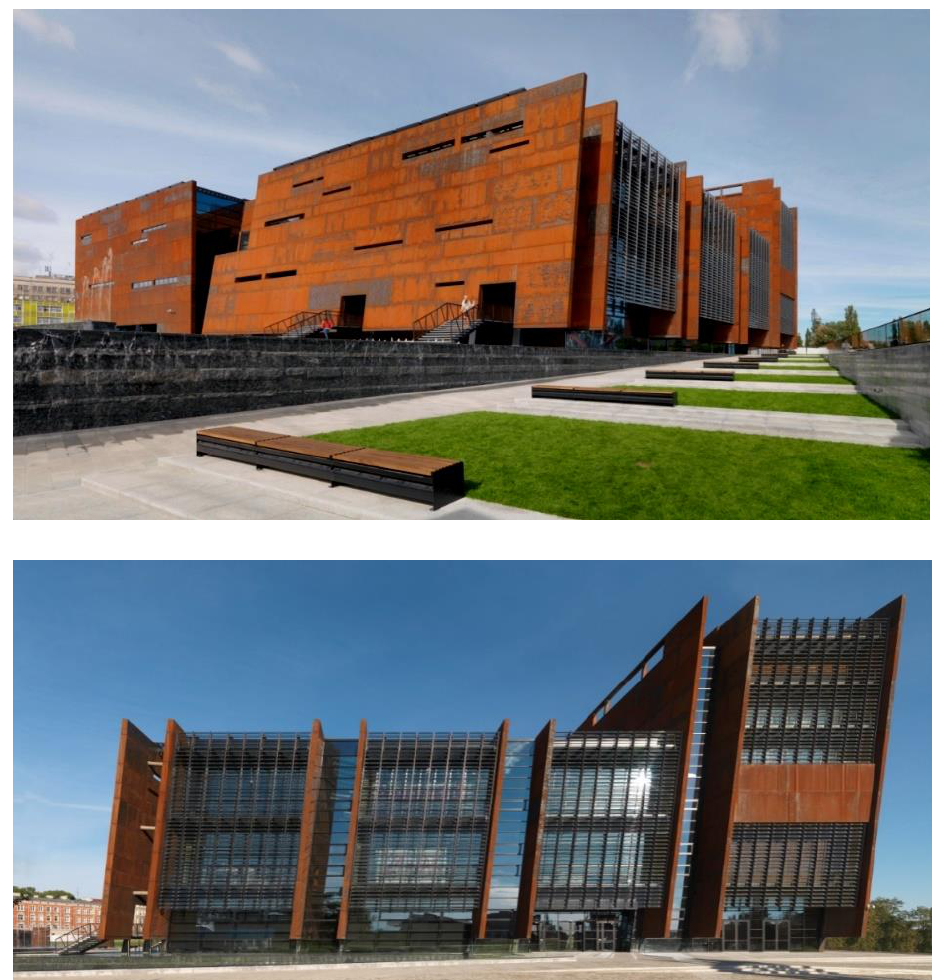
Figure 3. The south and west façade of the ECS, with structural walls which deviate from the vertical by 6.5°. The façades of the ECS are covered with 5 mm thick corten plates (photo by Wojciech Kryński) .